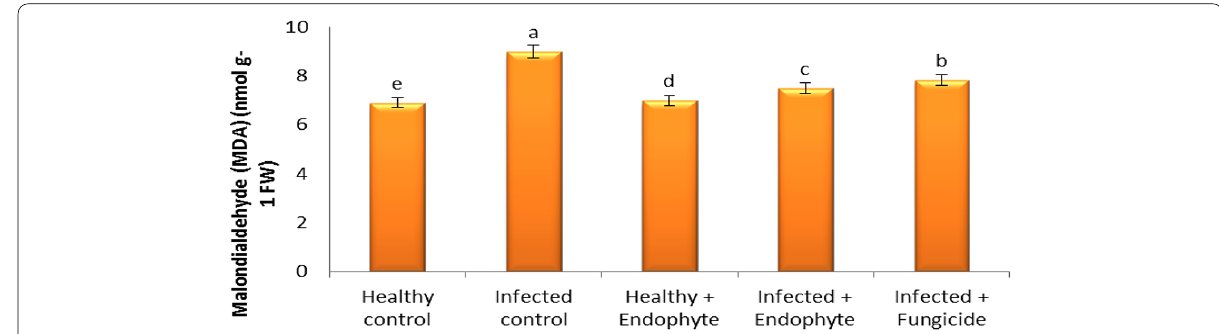
Fig. 5 Effect of A . terreus on Malondialdehyde of S. melongena